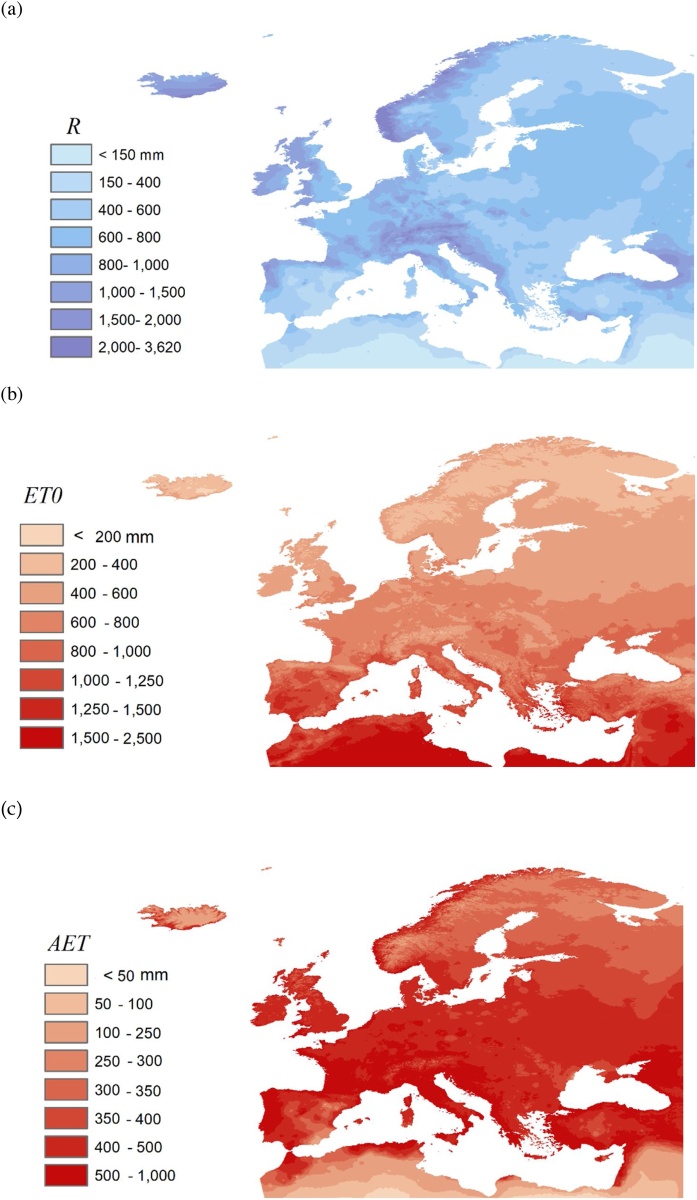
Maps of climatic predictors for each FUA: (a) Precipitation Rav,y, (b) potential evapotranspiration ET0av,y and (c) actual evapotranspiration AETav,y.